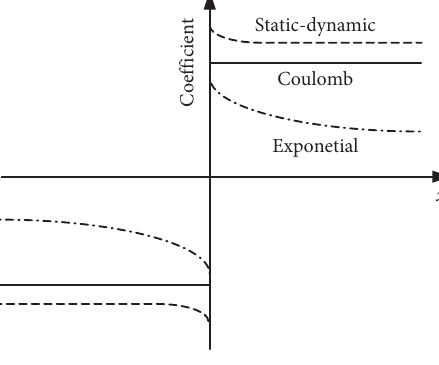
Figure 3: Friction